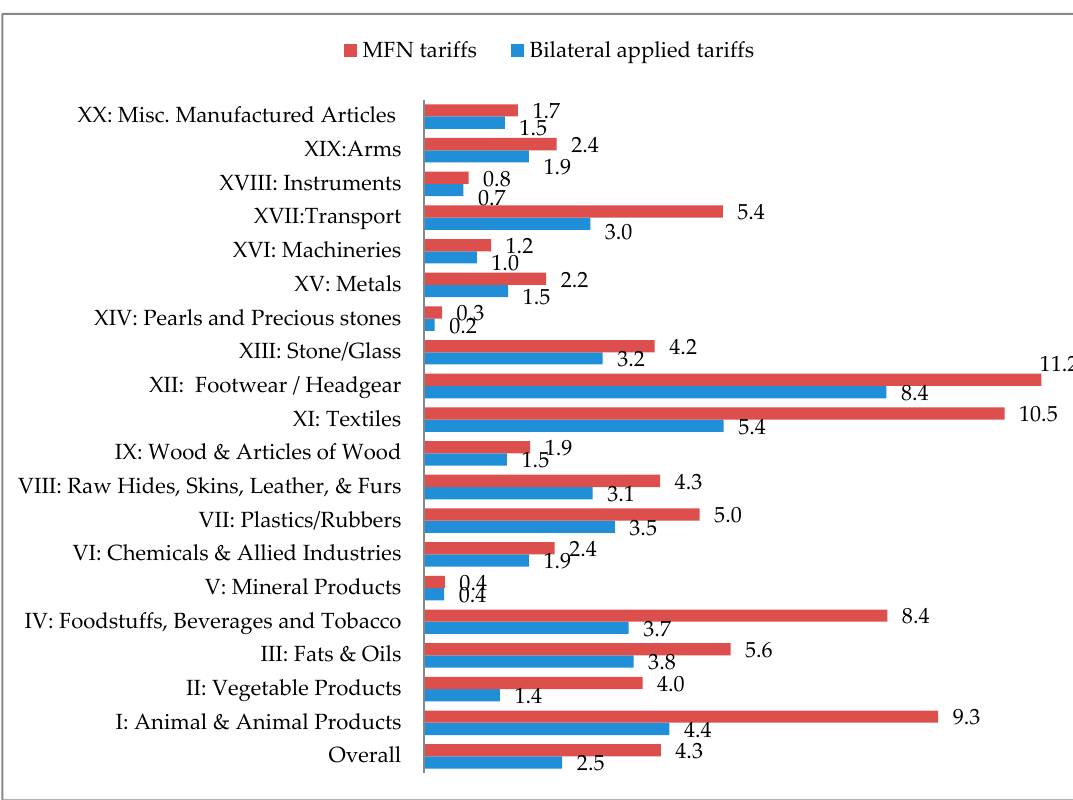
Table 1. Estimated elasticities of substitution by section.